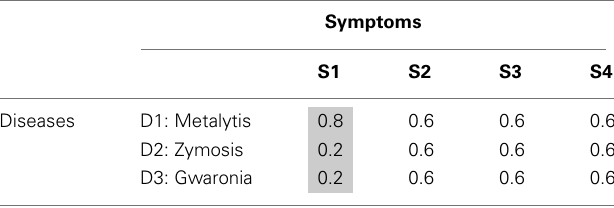
Table 1 | Disease × Symptom ecology of Experiment 1.